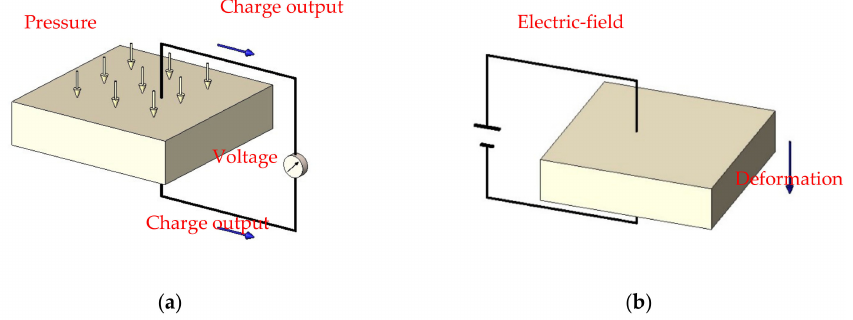
Figure 1. Piezoelectric e ff ect: ( a ) conversion of pressure into voltage di ff erence; ( b ) conversion of voltage into